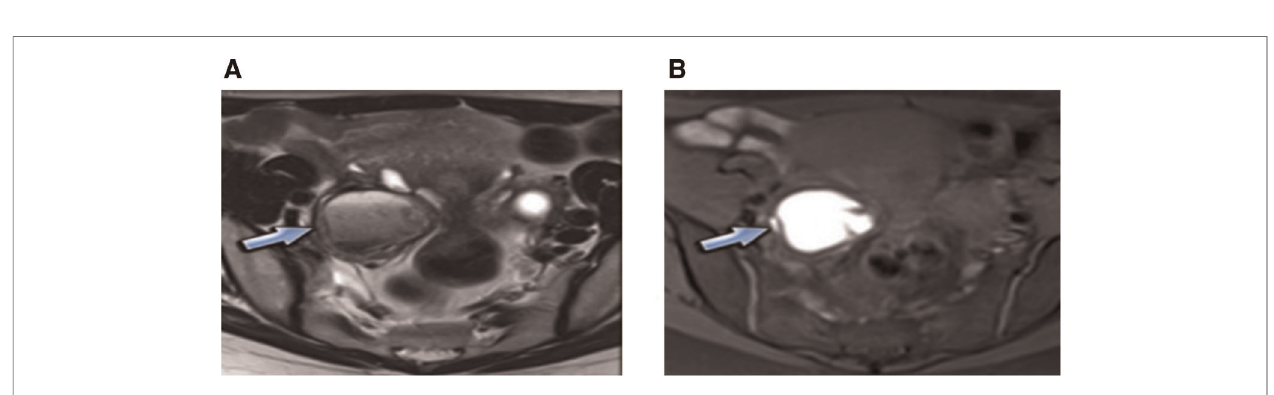
FIGURE 2 | Ureteral involvement. T1 TSE – VIBE, postcontrast agent, urographic sequences: ( A ) SAG, ( B ) Para-AX: high level (thin line), ( C ) Para-AX: medium level (thin line), ( D ) Para-AX: inferior level (thin line).